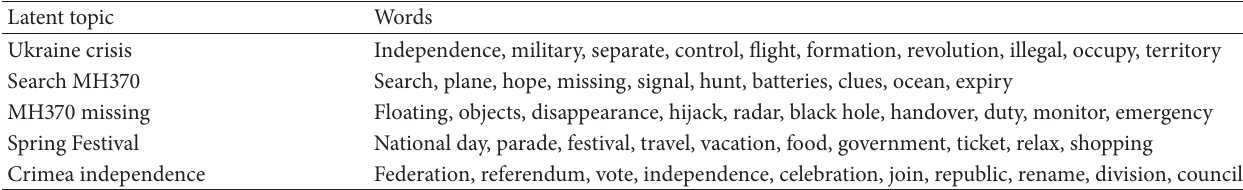
Table 1: The words distributed over five sample topics.